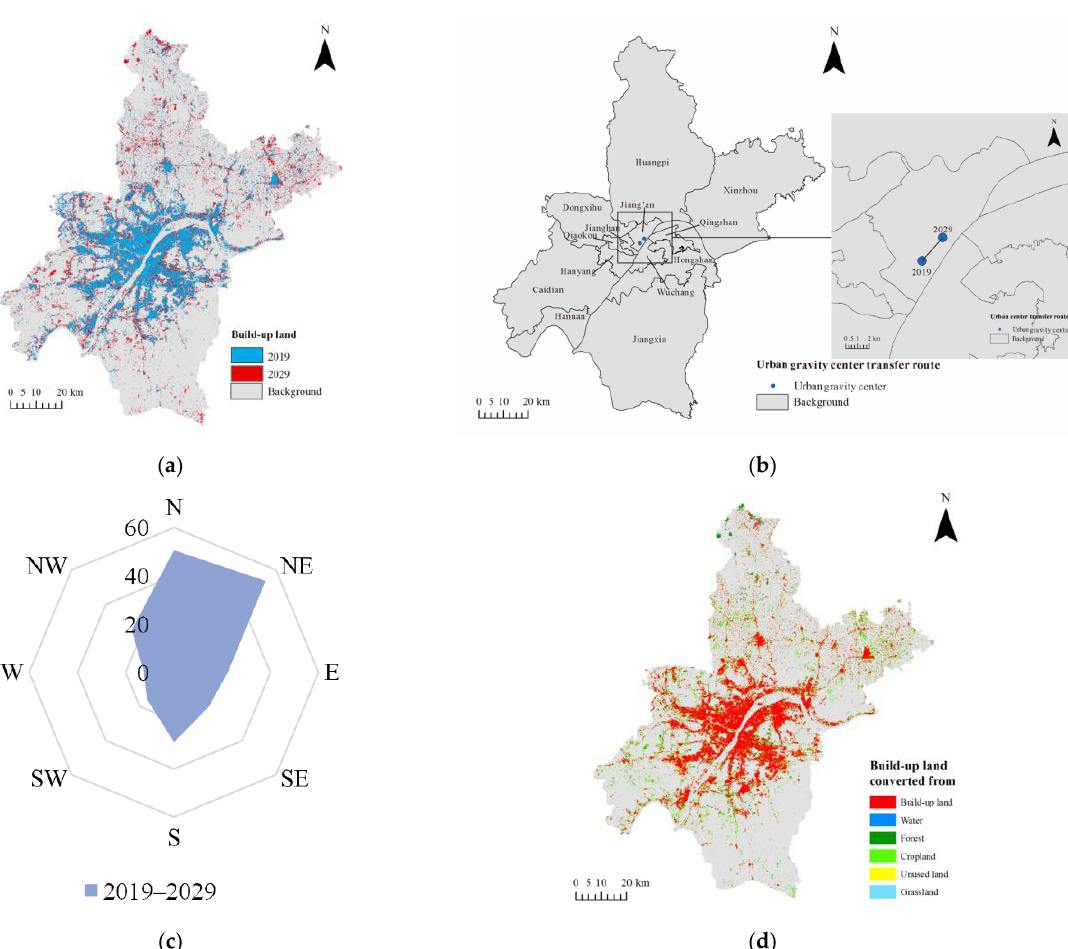
Figure 17. The future urbanization mode of Wuhan during the period 2019 – 2029: ( a ) the urban scope of typical years; ( b ) the urban gravity center transfer route; ( c ) the radar map of urban development direction; ( d ) the situation of urban land crowding out other land uses.